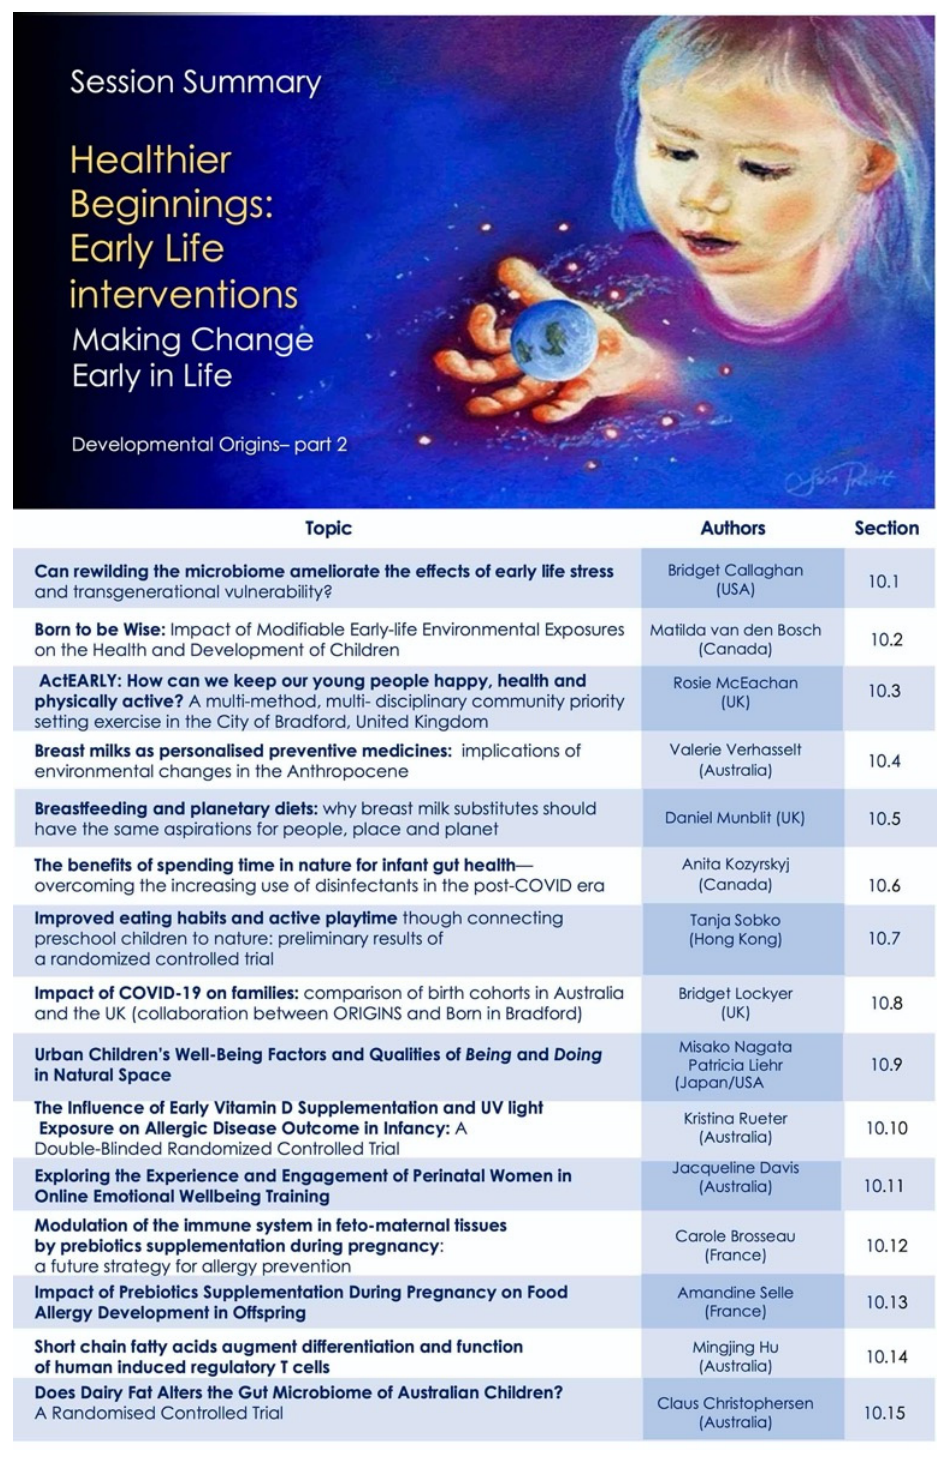
Figure 9. Healthier Beginnings: Early Life interventions: Overview of topics and speakers in the session on developmental ecology (Part 2).